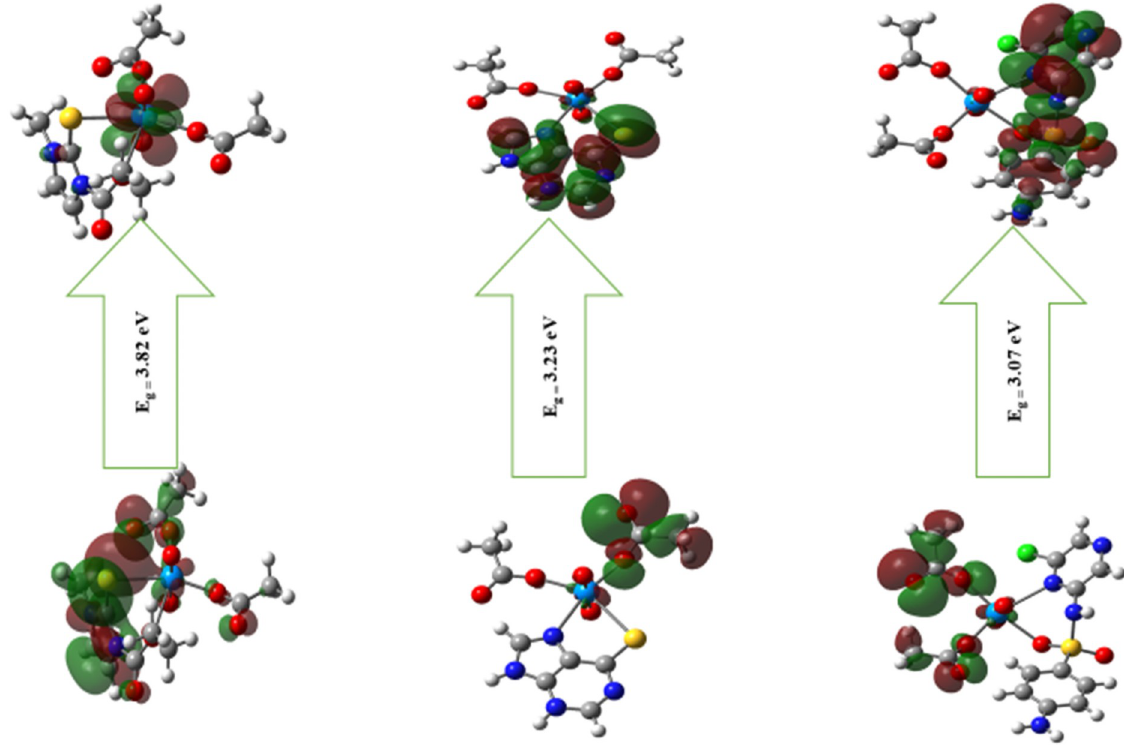
Fig 3. HOMO and LUMO orbitals of the investigated complexes using the B3LYP/SDD method.